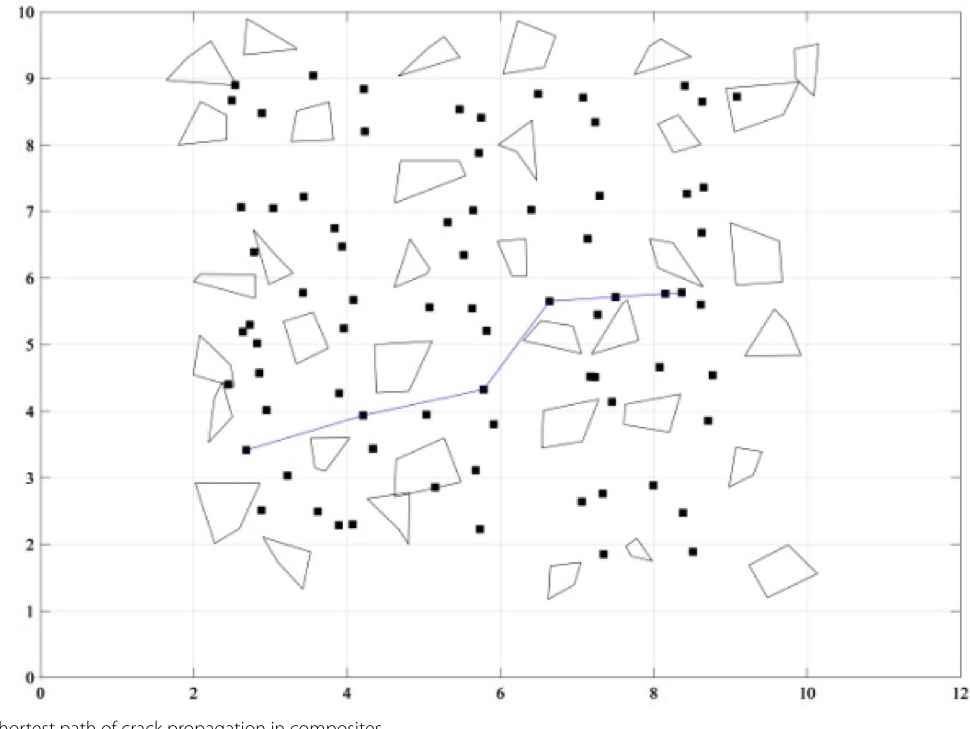
Figure 4 Shortest path of crack propagation in